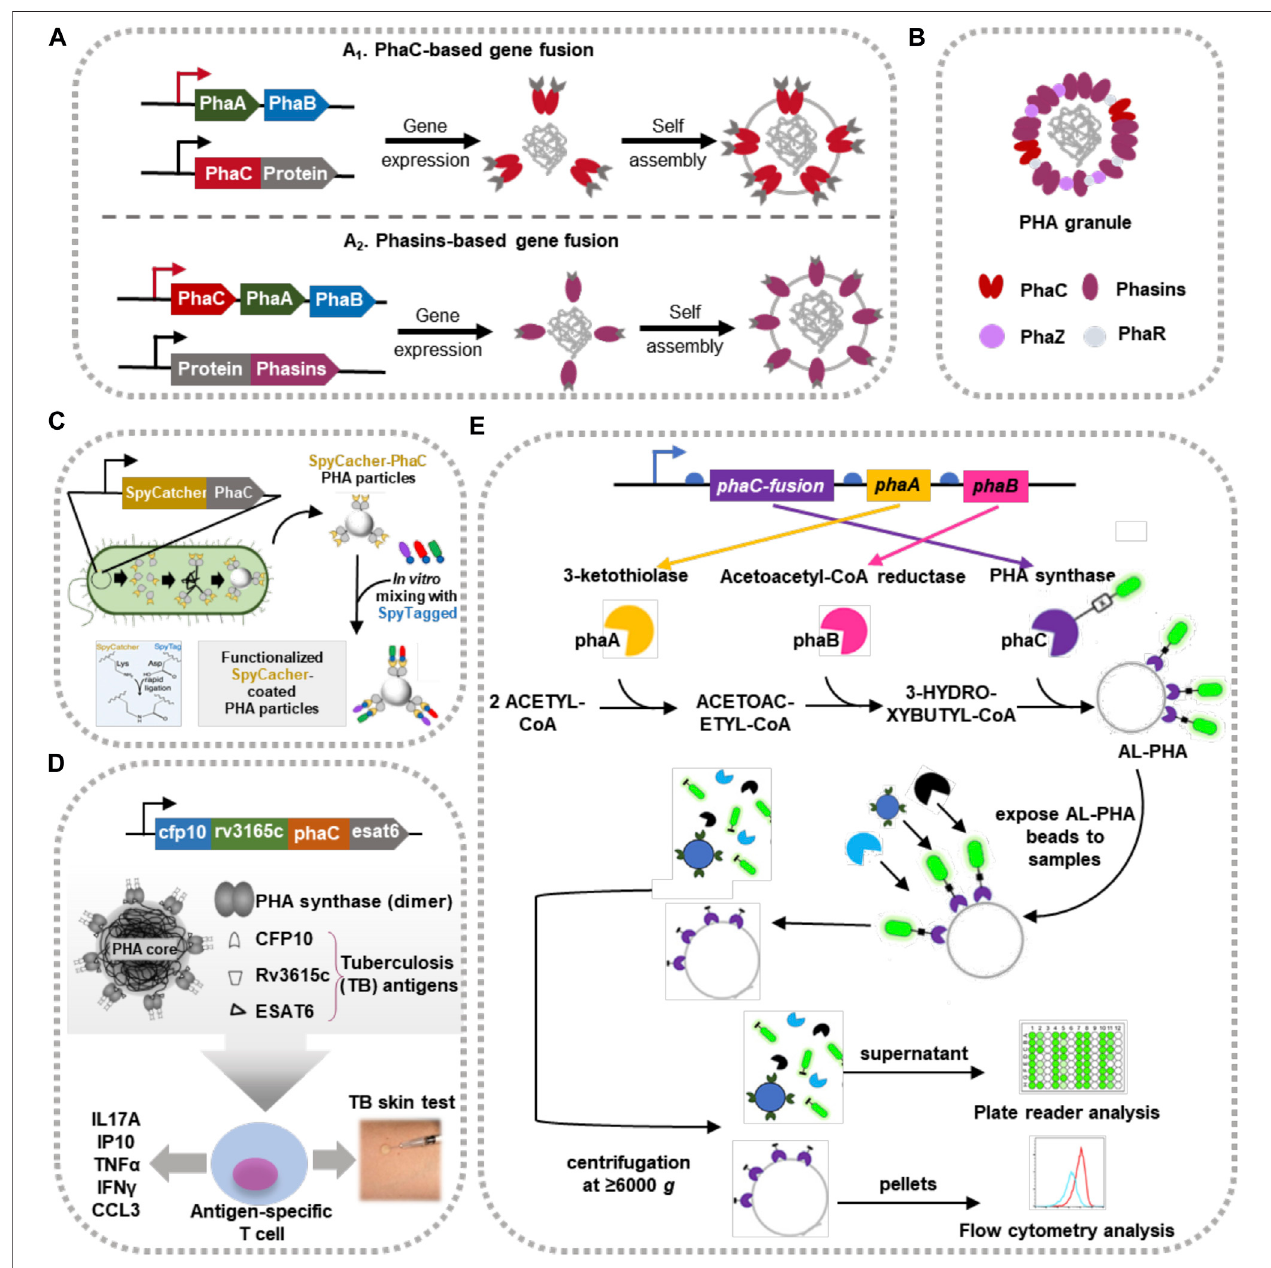
FIGURE 4 | Fabrication and applications of PHA-based BAS carriers. (A) Functionalization of self-assembled PHA granules using PhaC- (A 1 ) and phasins- (A 2 ) based fusion approach. (B) Structural schema of a natural synthesized PHA-protein complex. (C) Functionalized PHA particles coated with Spy-catcher tag to form immobilized biocatalysts scaffold. Regenerated from (Wong and Rehm, 2018) with permission. (D) TB antigens modi fi ed PHA particles as vaccine for skin test. Regenerated from (Parlane et al., 2017) with permission. (E) Schematic diagram of AL-PHA system (Advanced proteoLytic detector PolyHydroxyAlkanoates). Regenerated from (Kelwick et al., 2021) with